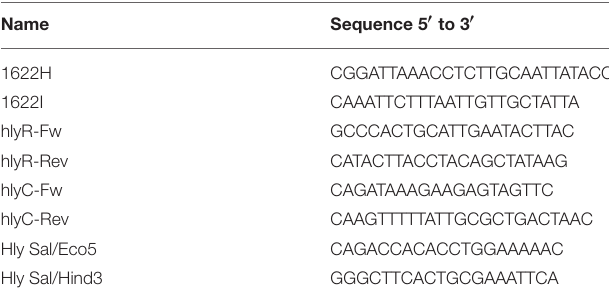
TABLE 1 | Oligonucleotides used in this